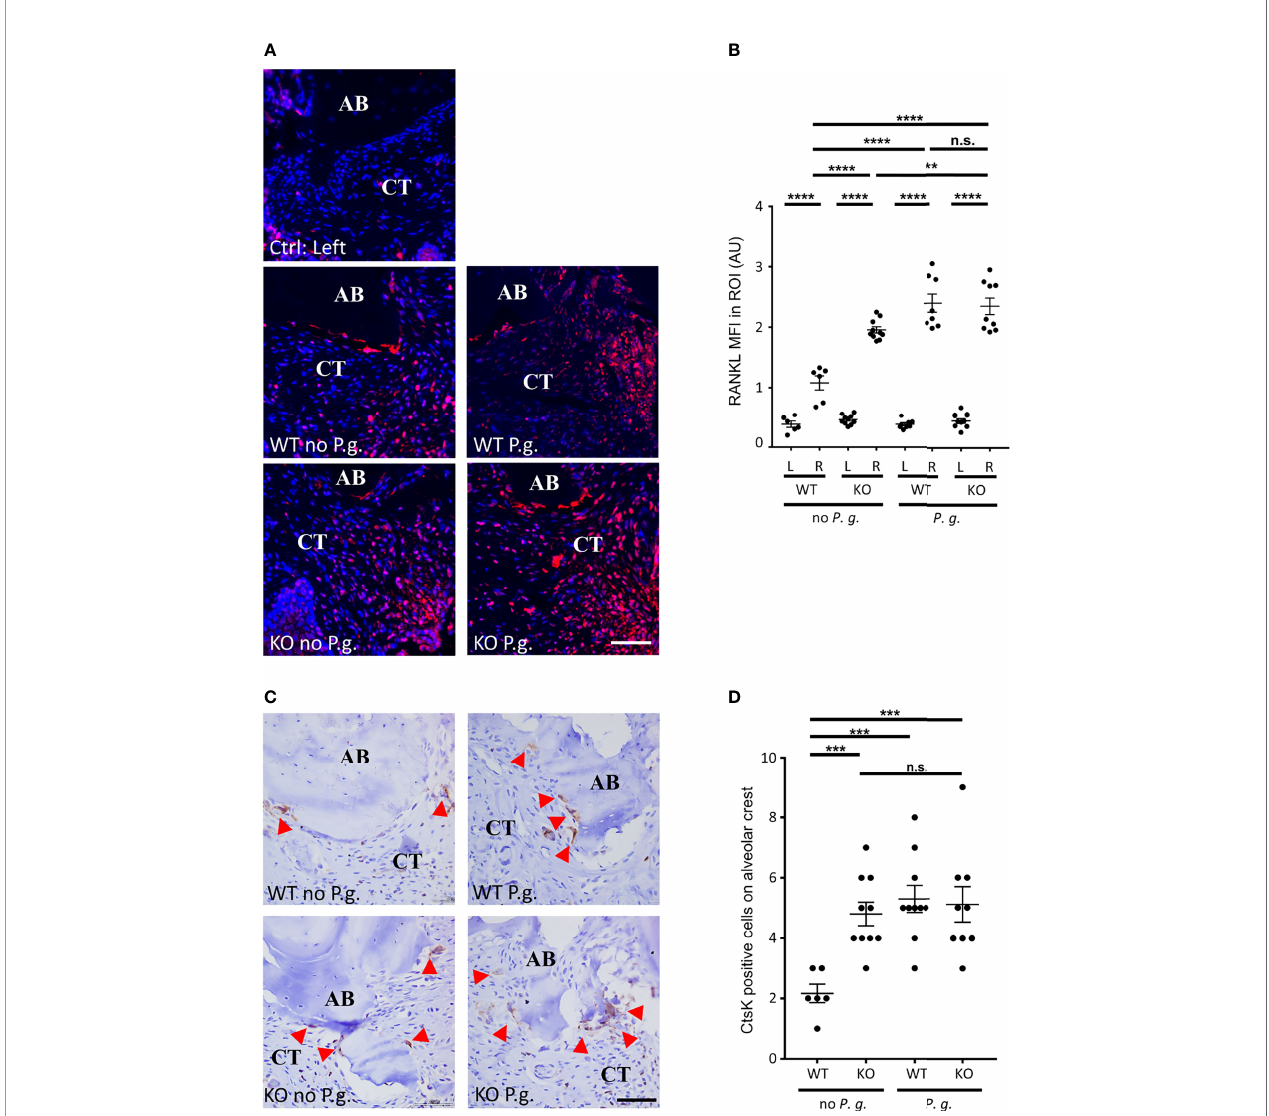
FIGURE 4 | Active osteoclasts and RANKL expression. (A) The expression of RANKL was revealed by immuno fl uorescence. The control without periodontitis induction (left side) is shown on the individual upper panel, the assays with ligature with or without P. gingivalis (right side) are shown on the 4 other panels (CT = connective tissue, AB = alveolar bone). (B) RANKL mean of fl uorescence intensity (MFI) was measured in a 0.082 mm 2 area (ROI) surrounding the alveolar bone crest. (C) Active osteoclasts were revealed by immunohistochemistry targeting the active osteoclasts marker Cathepsin K (Ctsk). Red arrowheads show Ctsk + osteoclasts. Only the right sides of treated mice are shown (CT = connective tissue, AB = alveolar bone). (D) The number of Cathepsin K-positive cells was counted in a 0.082 mm 2 area (ROI) surrounding the alveolar bone crest. Scale bars = 50 m m. (B, D) Each dot represents a single mouse. Horizontal bars represent the mean +/- SEM. Ordinary one-way ANOVA followed by uncorrected Fisher ’ s least signi fi cant difference (LSD) with a single pooled variance multiple comparison test. **P < 0.01, ***P < 0.001, ****P < 0.0001, n.s. P ≥ 0.05, non-signi fi